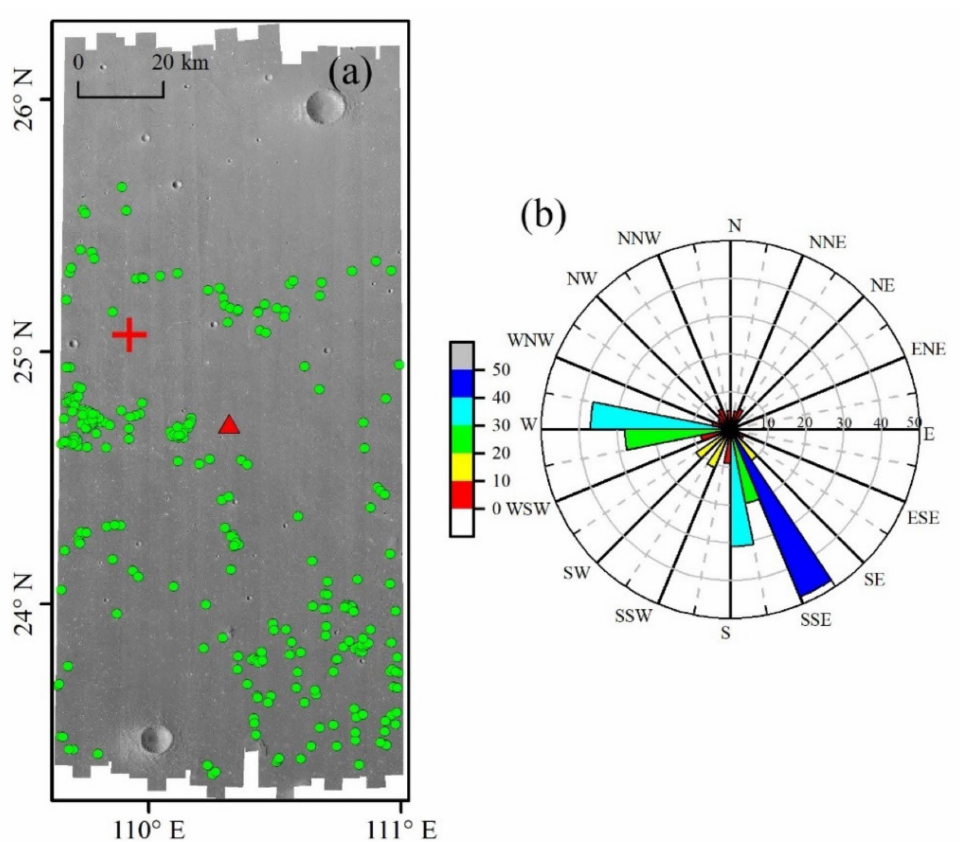
Figure 8. ( a ) Spatial distribution of the landing area cones. Green dots represent the cones. The red cross indicates the Zhurong landing site. ( b ) Rose diagram of the distribution of the landing area cones with 15 ◦ bin intervals indicates the number of cones in every separate region. The center of the rose diagram is consistent with the geometric center of the landing area (denoted by red